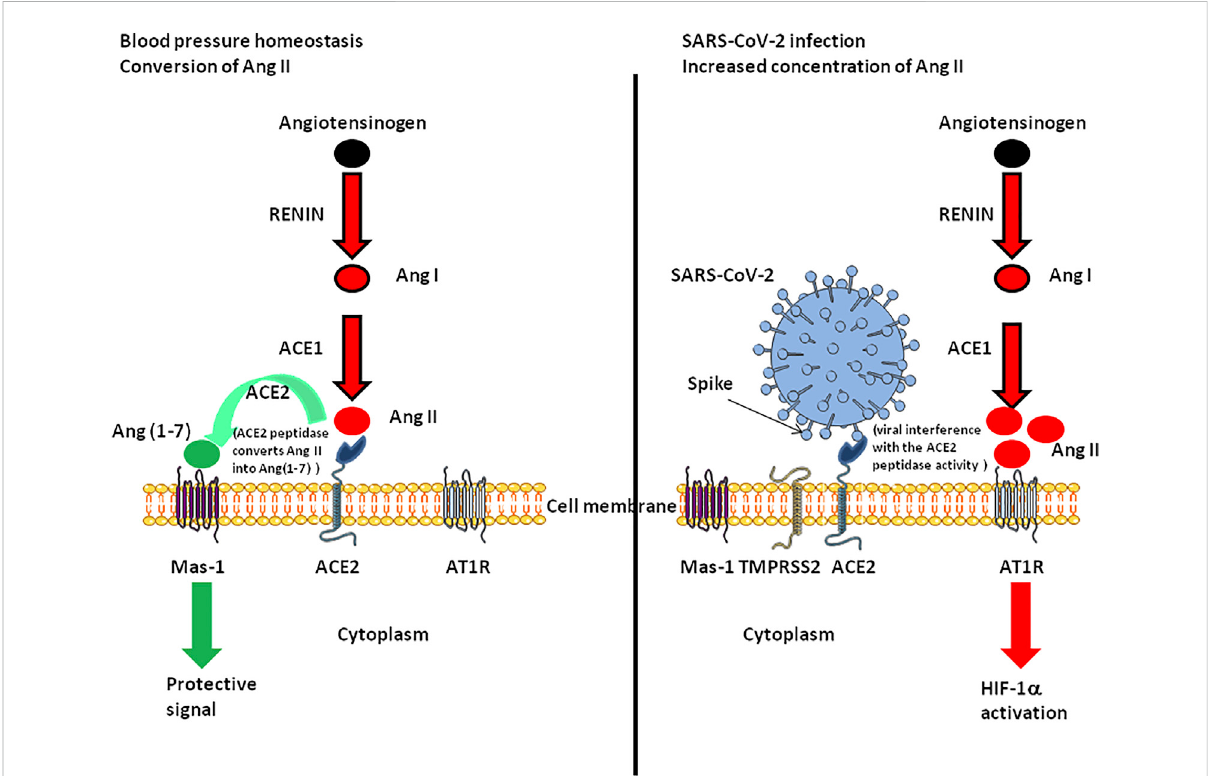
Schematic representation of the functioning of the renin-angiotensin system under normal conditions and during SARS-CoV-2 infection. The left panel illustrates the fact that ACE2 converts Ang II into Ang(1-7). Ang-(1-7) exhibits vasodilatory, anti-proliferative, and anti-in fl ammatory effects via the G protein-coupled receptor called Mas-1. The right panel illustrates the possible dysfunction of signals when SARS-CoV-2 is attached to its ACE2 receptor. Under this condition Ang(1-7) is no longer synthetised, Ang II accumulates and binds AT1R, leading to HIF-1 α